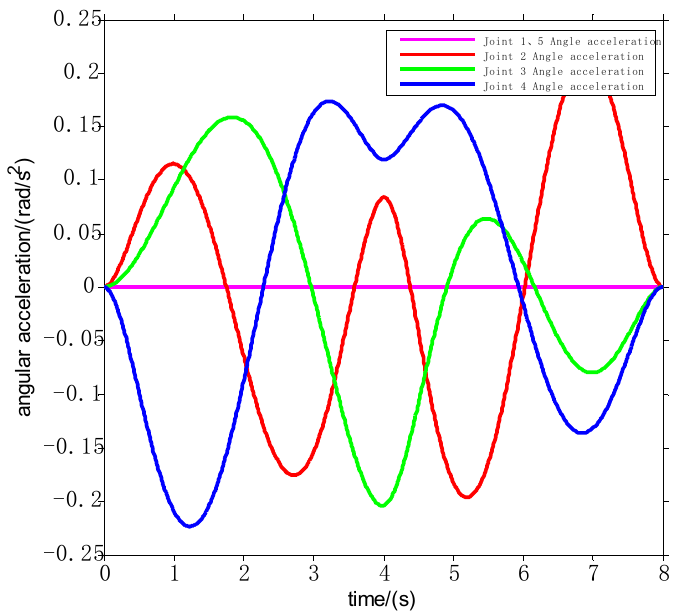
Figure 11. Spatial angular acceleration of the robot joint.